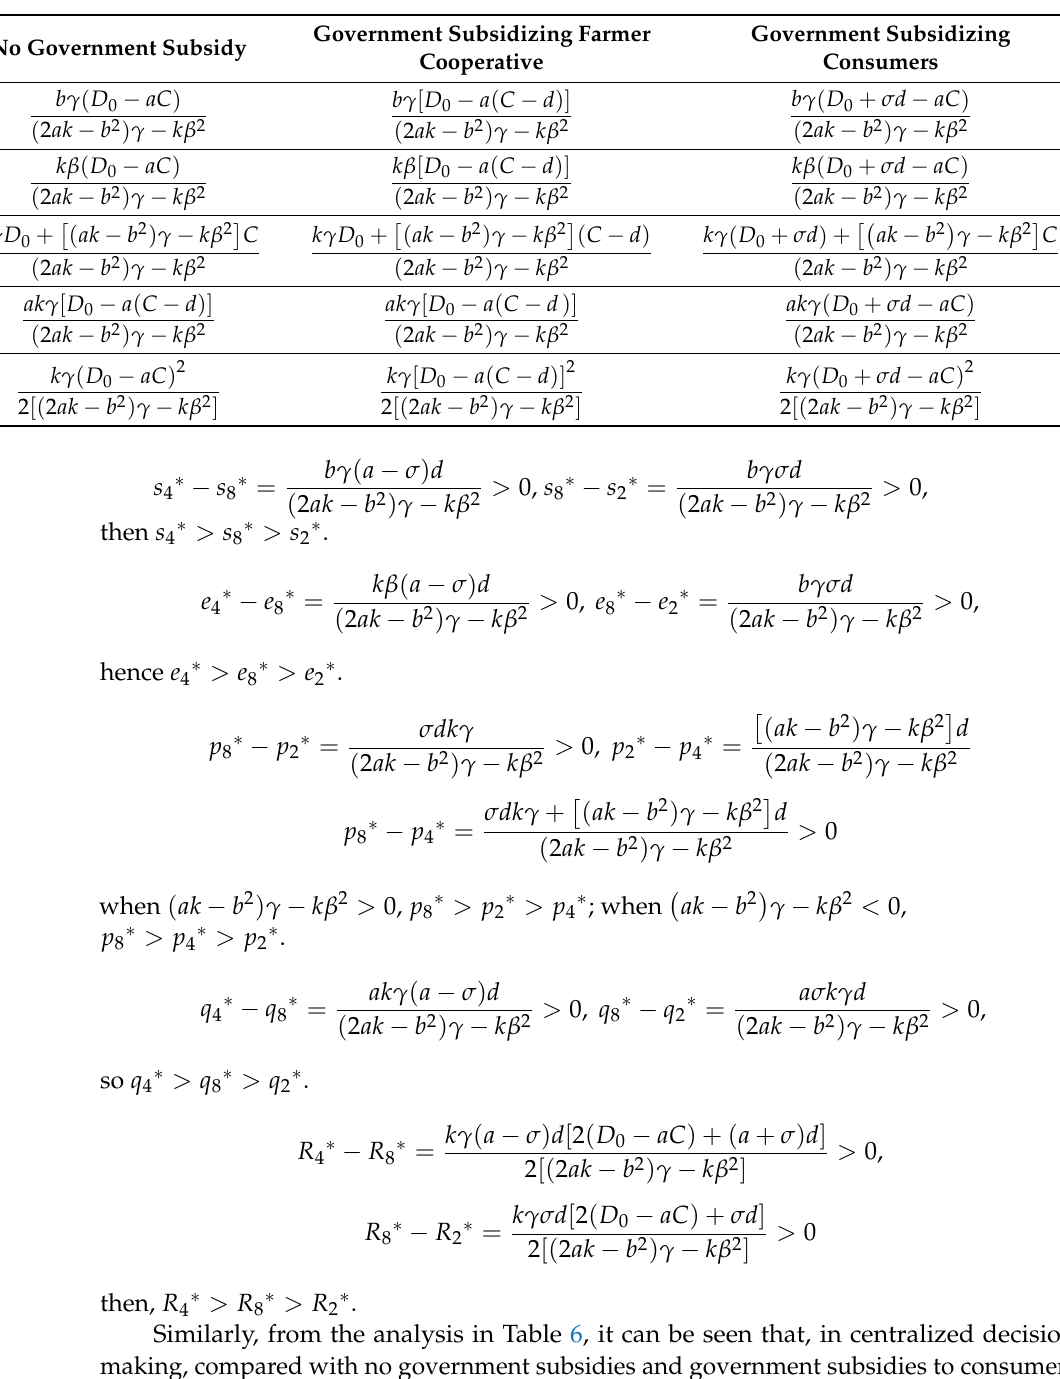
Table 6. Comparison of three strategies in centralized